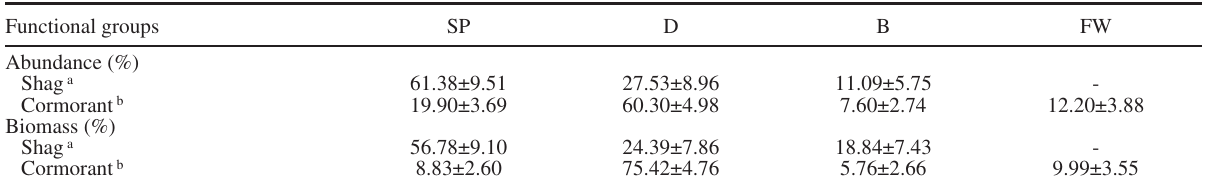
Table 3. – Abundance and biomass of fish functional groups (%; mean±standard error) included in shag and cormorant diet. Different superscript letters indicate significant differences between shag and cormorant during syntopy. SP, small pelagic; B, benthic; D, demersal; FW, freshwater.